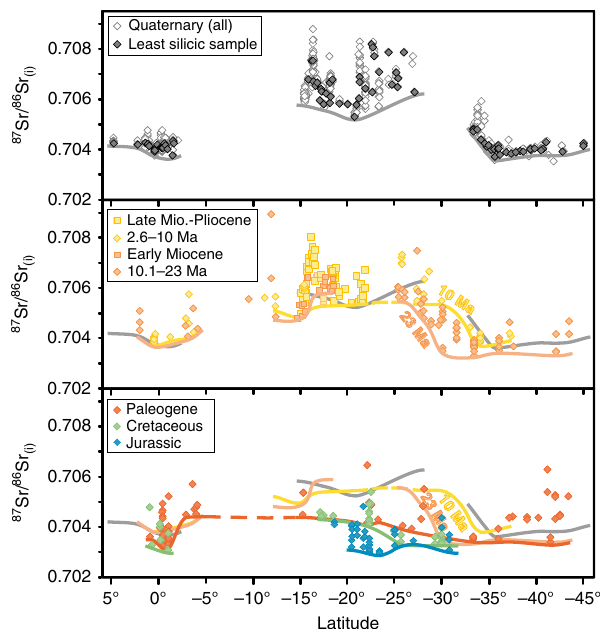
Fig. 5 Evolution of Andean arc initial Sr isotope compositions from the Jurassic to present. Age-corrected Sr isotope ratios of arc lavas (compilation of this study, Supplementary Data 3) grouped by age show the gradual increase in 87 Sr/ 86 Sr (i) with time. Baselines are drawn joining minimum values for each age group. Symbols are bigger than the maximum analytical error. For distribution of CVZ analyses versus age, please see Supplementary Fig.